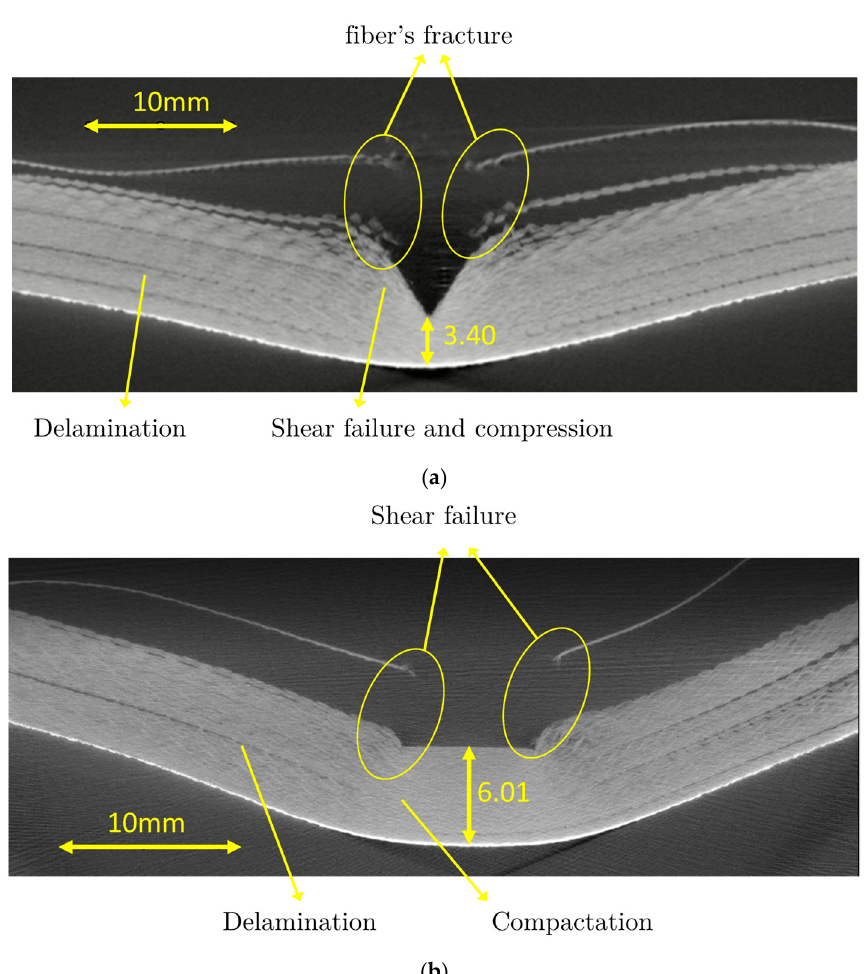
Figure 10. Tomography of different plates impacted to 454 J (V o = 174 m/s). ( a ) Conical projectile test; ( b ) Blunt projectile test.